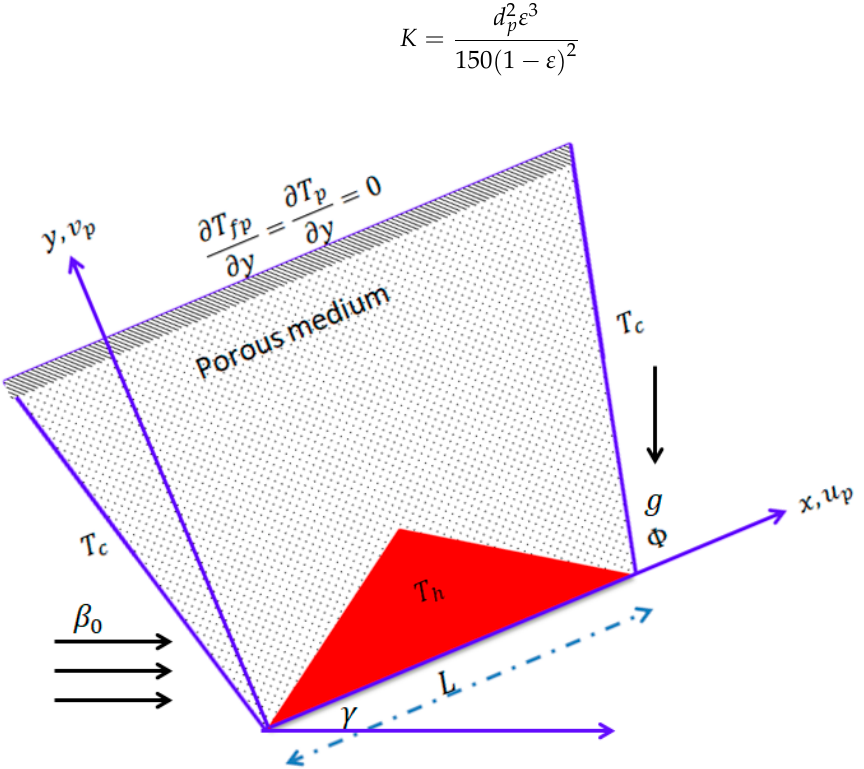
Figure 1. Schematic diagram of the current model.